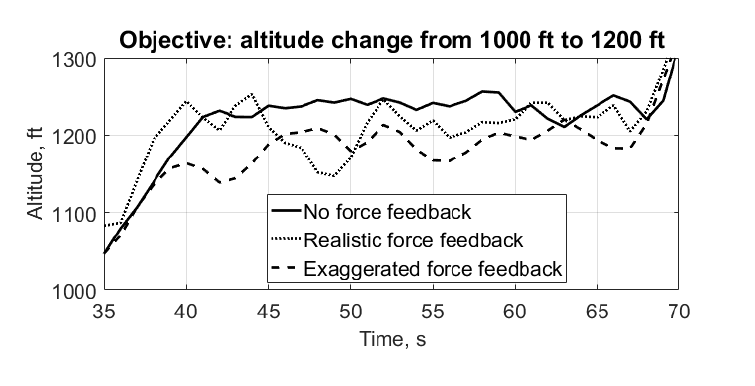
Figure 9. Altitude analysis at 1000 ft.